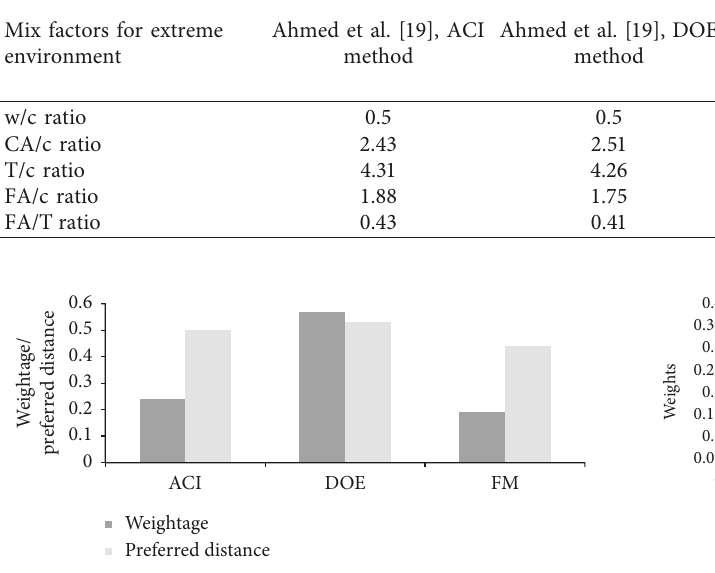
Figure 3: Ranking of mix design method for extreme environment using AHP and two-phase AHP-TOPSIS approach.